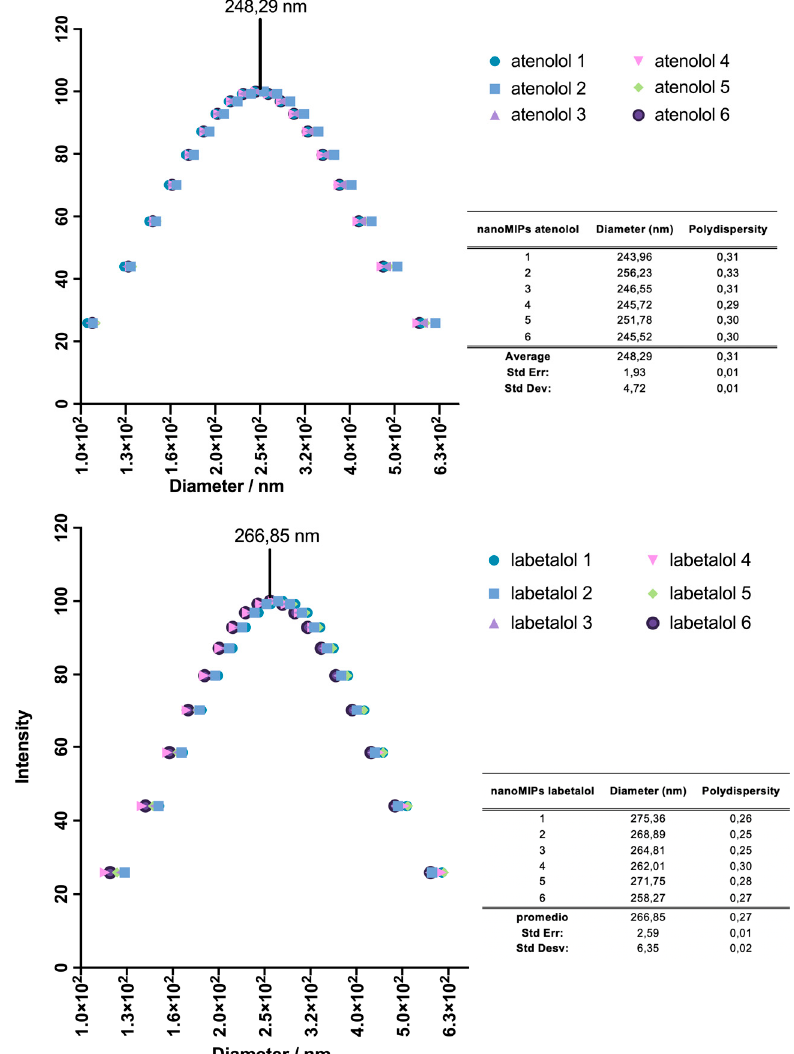
Figure 2. DLS graphs of the nanoMIPs-A ( top ) and nanoMIPs-L ( bottom ). On the right are tables including values of D and PDI of the nanoparticles.